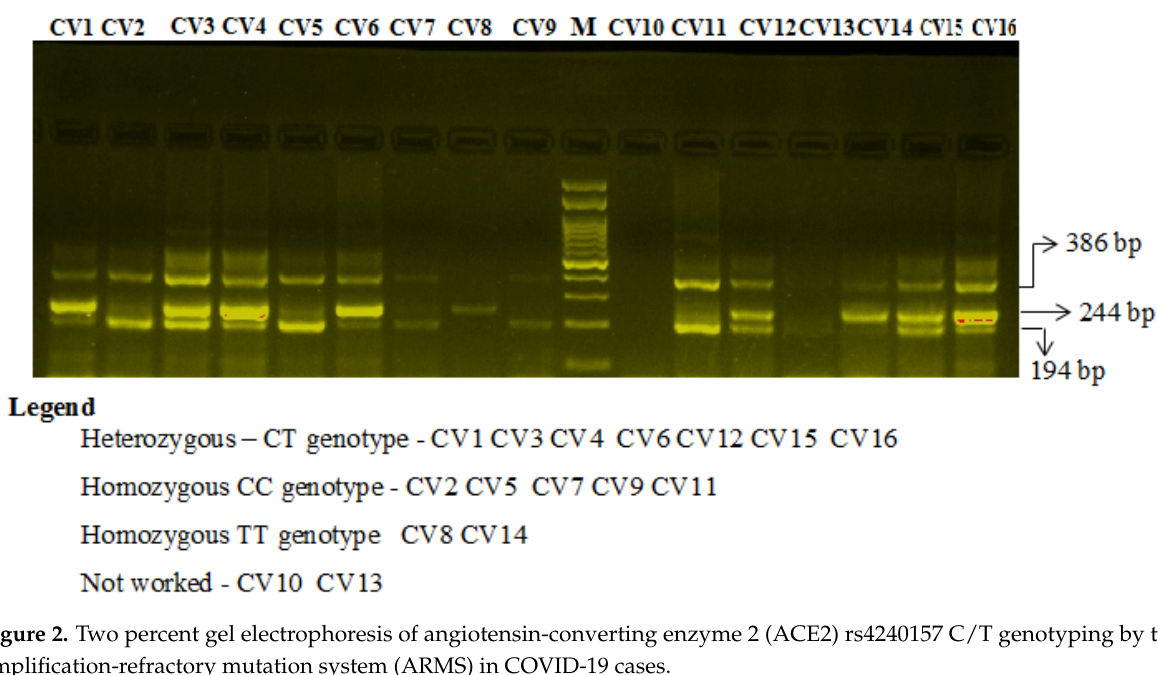
Figure 1. Detection of Angiotensin I ‐ converting enzymes (ACE2) insertion/deletion (I/D) rs4343 gene polymorphism.